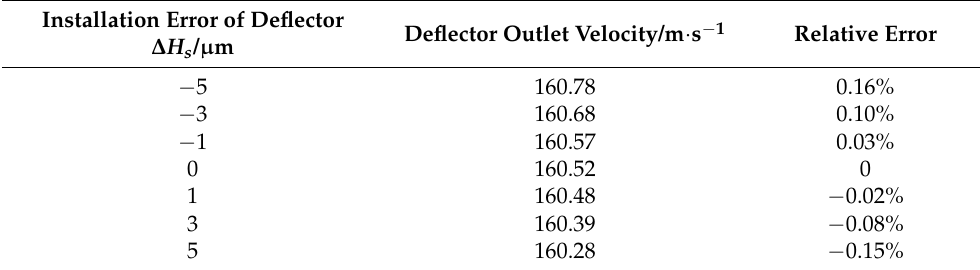
Table 5. Installation error dependence of the deflector outlet velocity. Installation Error of Deflector ∆ H s / µ m